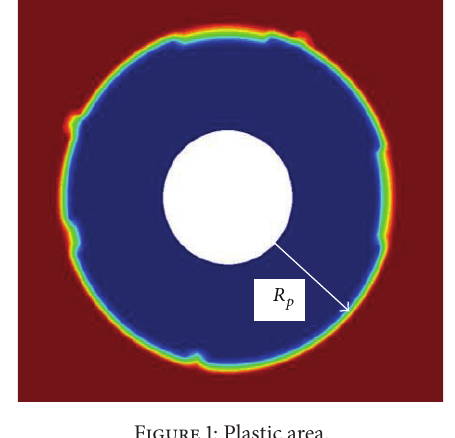
Figure 1: Plastic area.